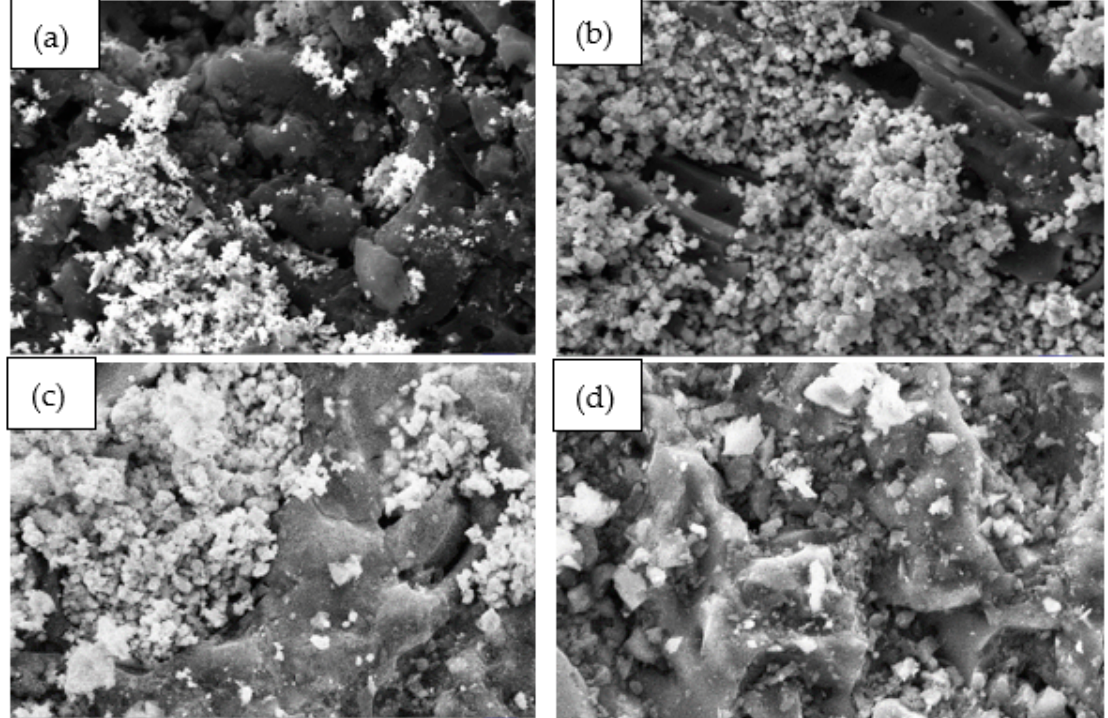
Figure 2. SEM morphological images for fresh DCM adsorbent with scale magnified by 2.5 Kx (2 μ m). ( a ) ZnAc 2 /ZnO/CAC_DCM, ( b ) ZnAc2/KOH/CAC_DCM, ( c ) ZnAc2/TiO2/CAC_DCM, and ( d ) ZnAc2/CAC_SI.